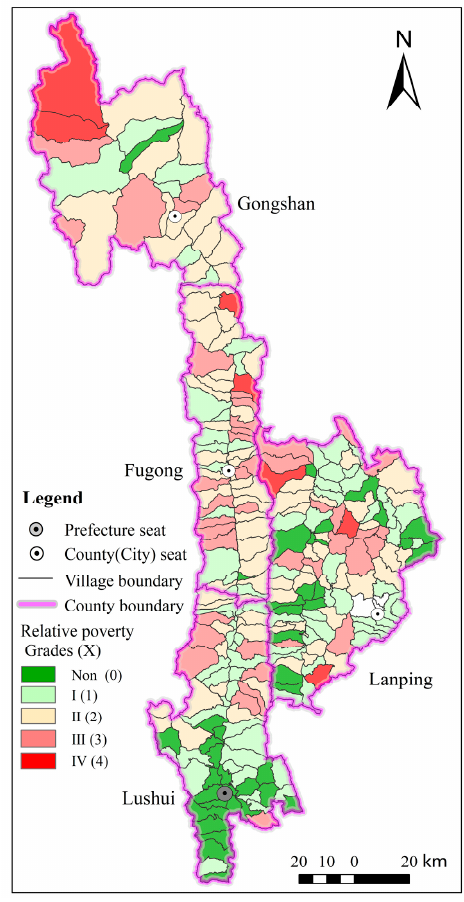
Figure 4. Distribution of multi-dimensional relatively poverty villages in Nujiang Prefecture. In the 215 relative poverty villages, the number of relative poverty grades I, II, III, and IV was 84, 82, 42, and 7, respectively. The relatively poor villages with poverty levels I and II, which fall into the mild poverty level, account for 77.21% of all poor villages; this demonstrated that Nujiang Prefecture’s relatively poor villages had a high potential for poverty